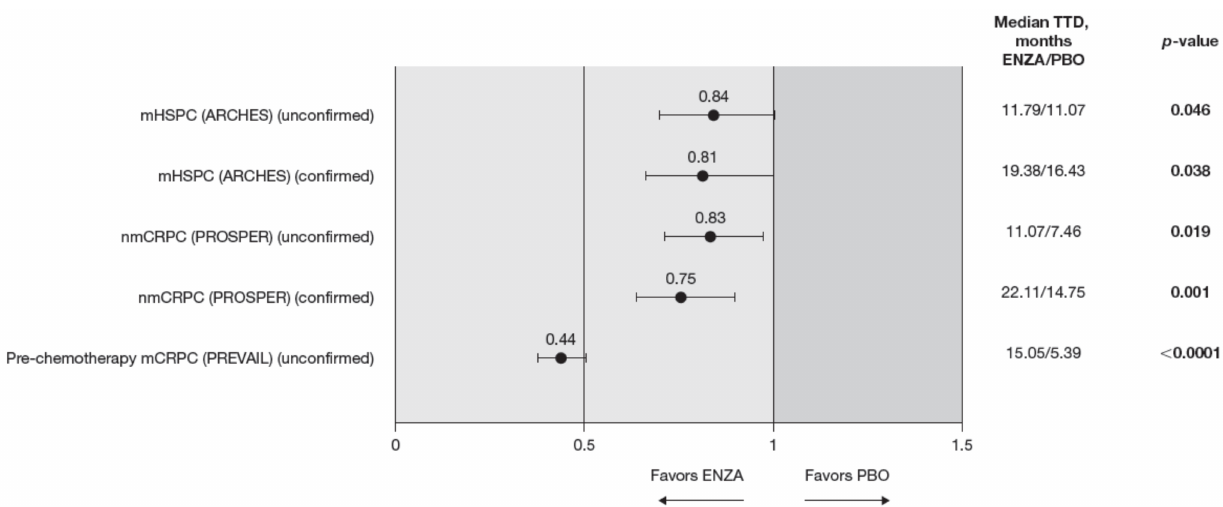
Figure 8. VAS score TTD. To meet criteria for “confirmed” time to first deterioration, the initial (unconfirmed) report of deterioration had to be verified at the next consecutive study visit. The EQ-5D-5L VAS was not collected in the AFFIRM pivotal trial. Abbreviations: ENZA: Enzalutamide; EQ-5D-5L: EuroQol 5-Dimension 5-Level questionnaire; mCRPC: Metastatic castration-resistant prostate cancer; mHSPC: Metastatic hormone-sensitive prostate cancer; nmCRPC: Non-metastatic castration-resistant prostate cancer; PBO: Placebo; TTD: Time to deterioration; VAS: Visual Analog